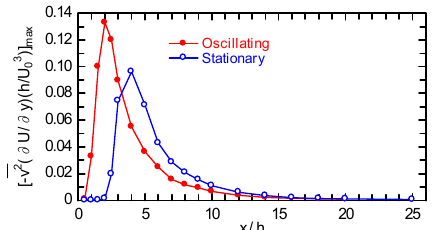
Fig. 7 Streamwise variation of maximum production rates of Reynolds shear stress